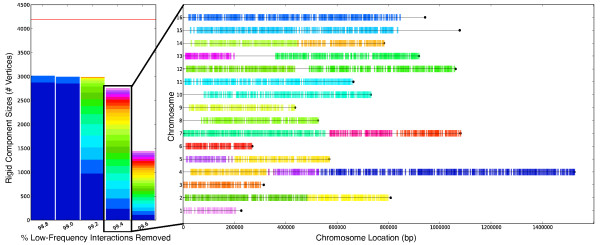
Effect of low-frequency interactions on rigid components. (Left) Sizes of rigid subgraphs after removing various percentages of low-frequency interactions for the Duan et al. chromosome conformation graph. The rigid subgraphs at a particular cutoff are sorted and colored by size. The horizontal red line represents the total number of nodes in the chromosome conformation graph before filtering. (Right) The chromosomal locations of rigid components after removing 99.4% of low-frequency interactions. Bars indicate centers of the fragments involved in a rigid component, and colors indicate the various components.